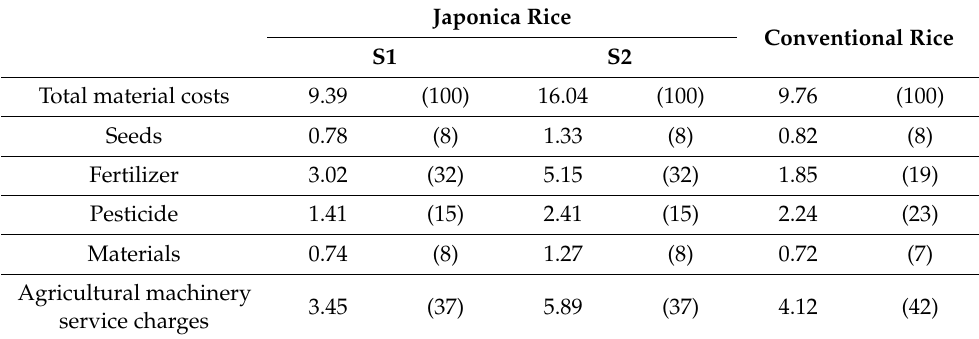
Table 3. Comparison of material costs between japonica rice and conventional rice (unit: KSh/kg).